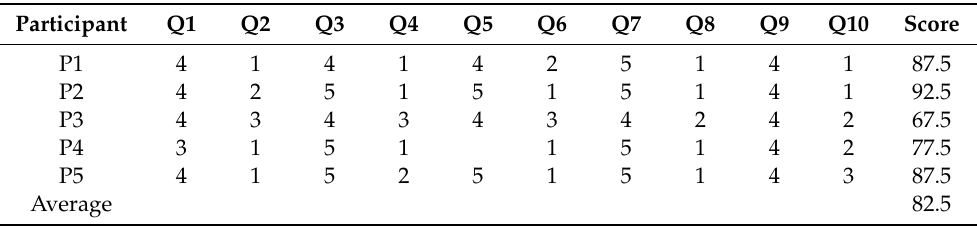
Table 13. System usability scale